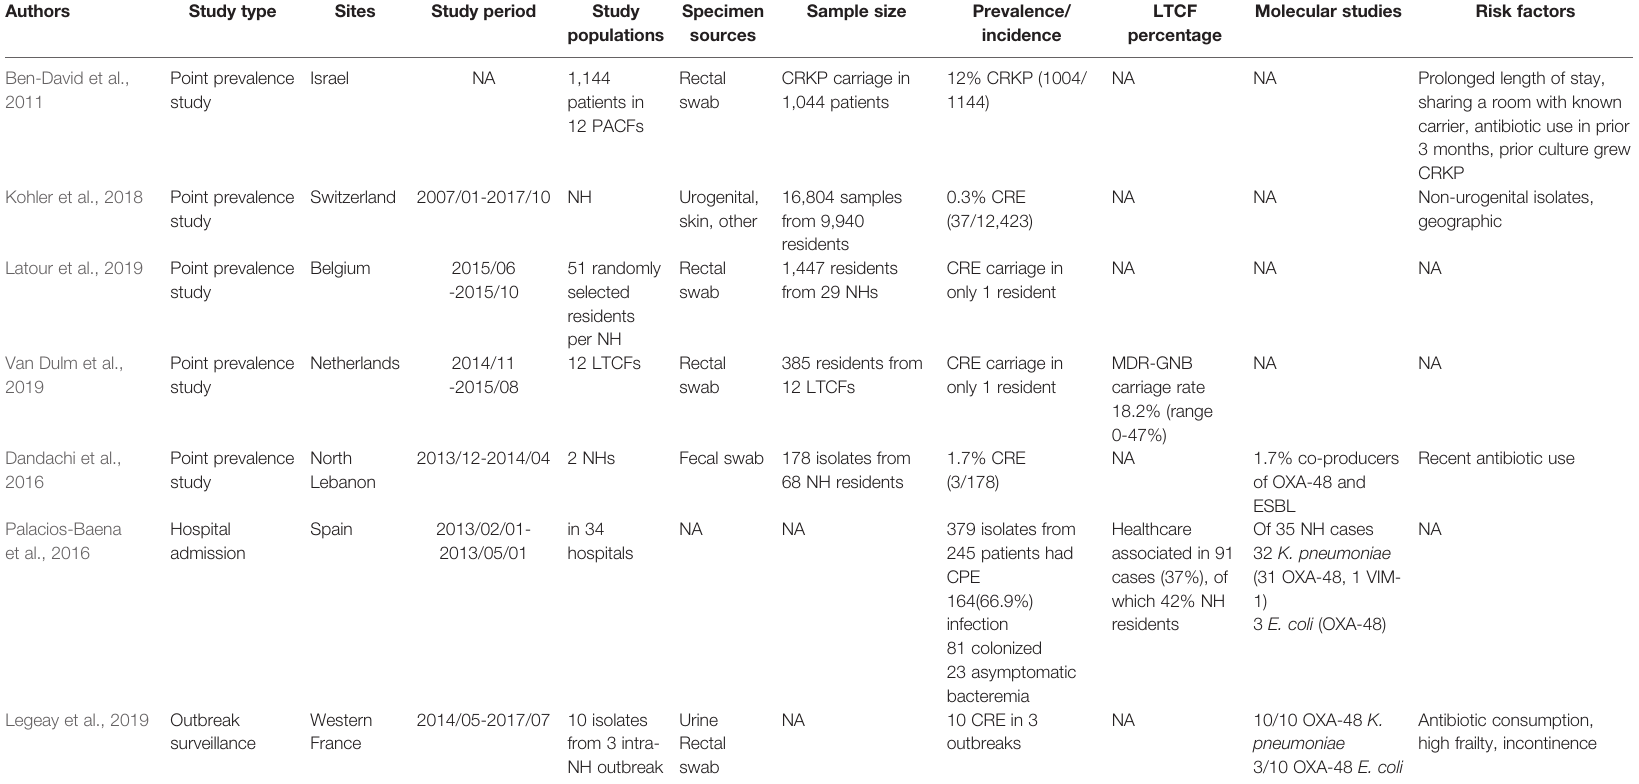
TABLE 2 | Studies carbapenem-resistant Enterobacterales colonization in long-term care facilities in the Europe.